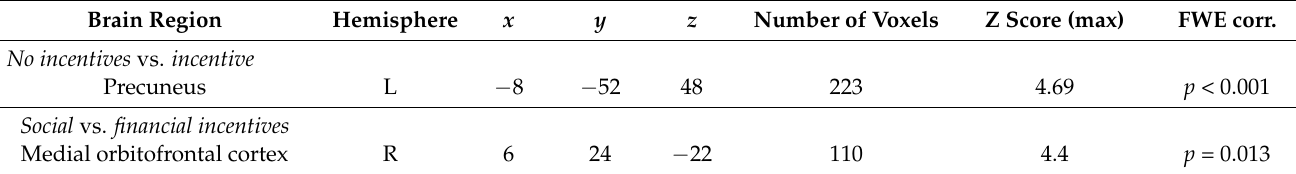
Table 2. Brain activations related to the decision-making model (GLM 2, time locked to screen V). All reported activations survived a threshold corresponding to p < 0.05, FWE corrected for multiple comparisons at the cluster level, with an underlying threshold corresponding to p < 0.001 uncorrected at the whole-brain level. Abbreviations: L/R: left/right; x , y , and z : coordinates in MNI